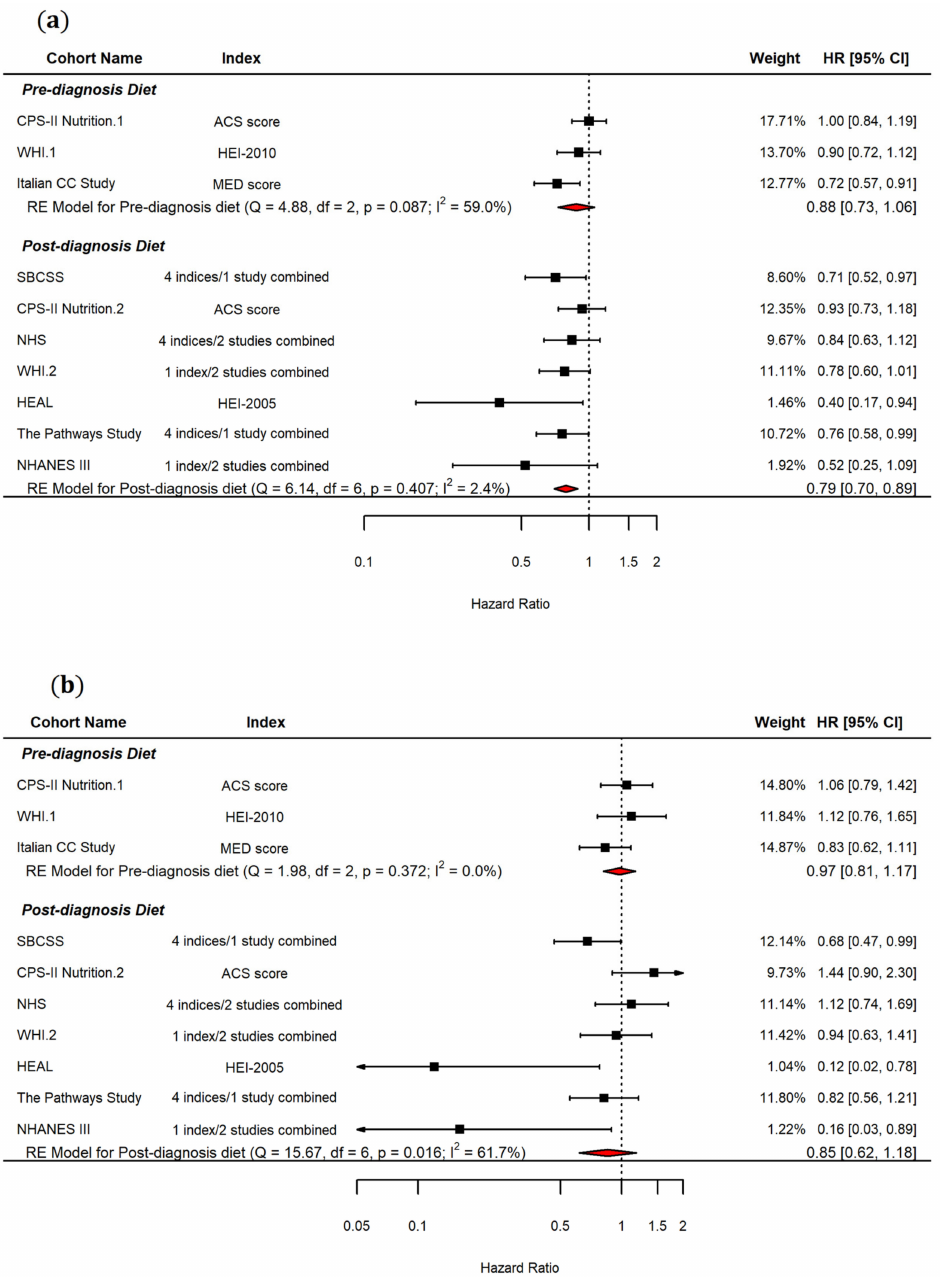
Figure 3. Forest plot showing pooled hazard ratios (HRs) with 95% confidence interval (CI) for association between highest vs. lowest diet quality and risk of all-cause mortality ( a ) and breast cancer- specific mortality ( b ) in cohort study, cohort as the unit of analysis. ACS: American Cancer